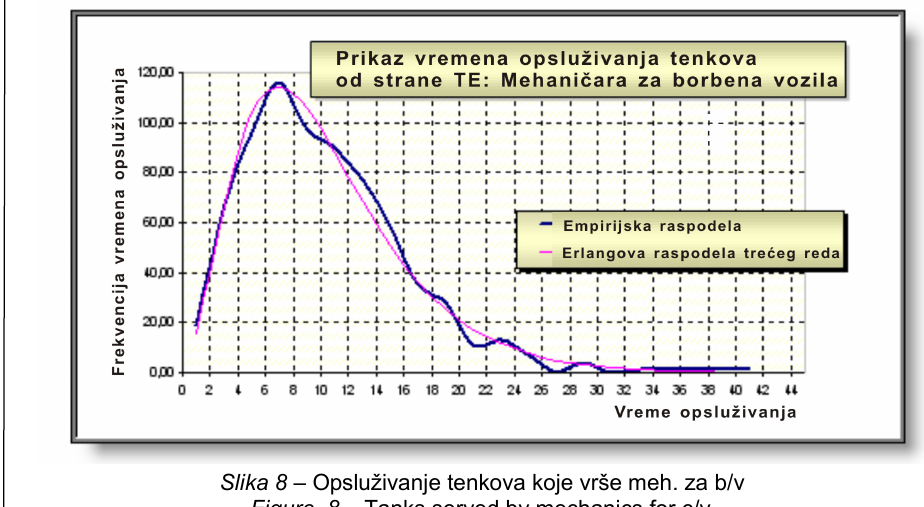
Figure 8 – Tanks served by mechanics for